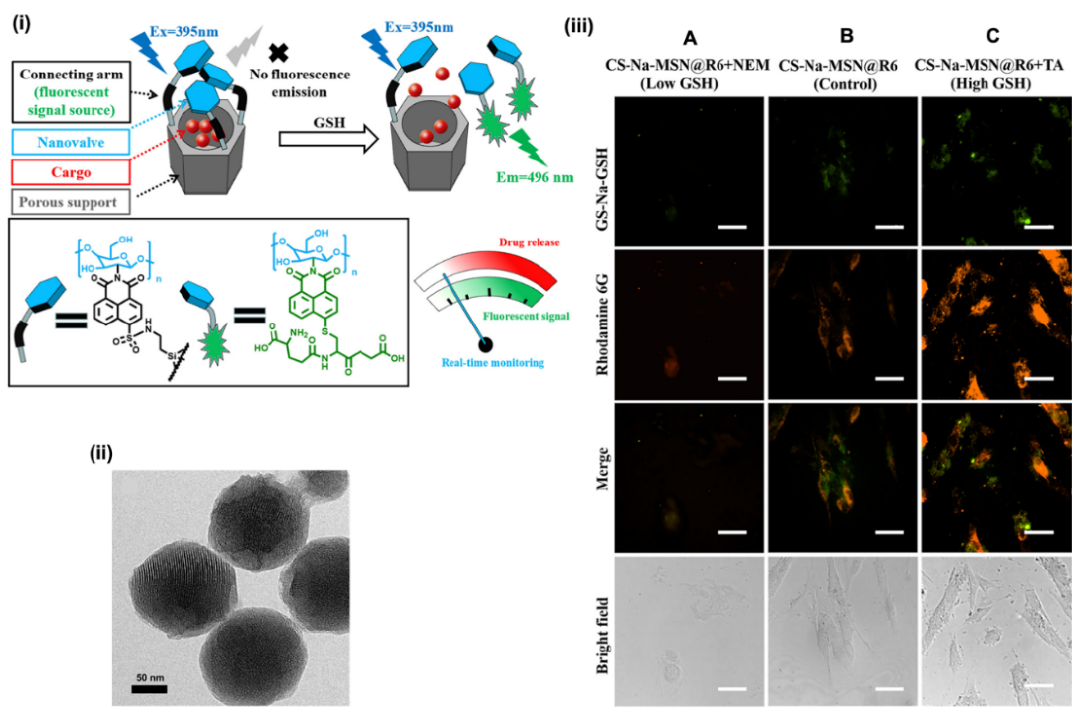
Figure 10. Chitosan-gated fluorescent mesoporous silica nanoparticles (FMSNs). ( i ) Schematic illustration of the design of chitosan-gated MSNs for monitoring drug release in vitro. The as-synthesised nanoparticles are composed of naphthalimide-dye-functionalised chitosan (Cs-Nac) as the gatekeeper, an MSN nanoparticulate scaffold and Rhodamine 6G (R6) as the model cargo agent. On glutathione (GSH) addition two fluorescent emissions corresponding to the release of R6 and cleaved Cs-Nac are observed. ( ii ) A TEM image of as-synthesised MSNs. ( iii ) Fluorescence images of MRC–5 cells with different GSH concentration. (A) The as-synthesised MSNs with low GSH concentration. (B) MSNs in MRC-5 without any other treatment. (C) MSNs with high GSH concentration. Adapted with permission from reference [126]. Copyright (2020) American Chemical Society.